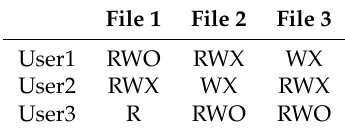
Table 1. Access Control